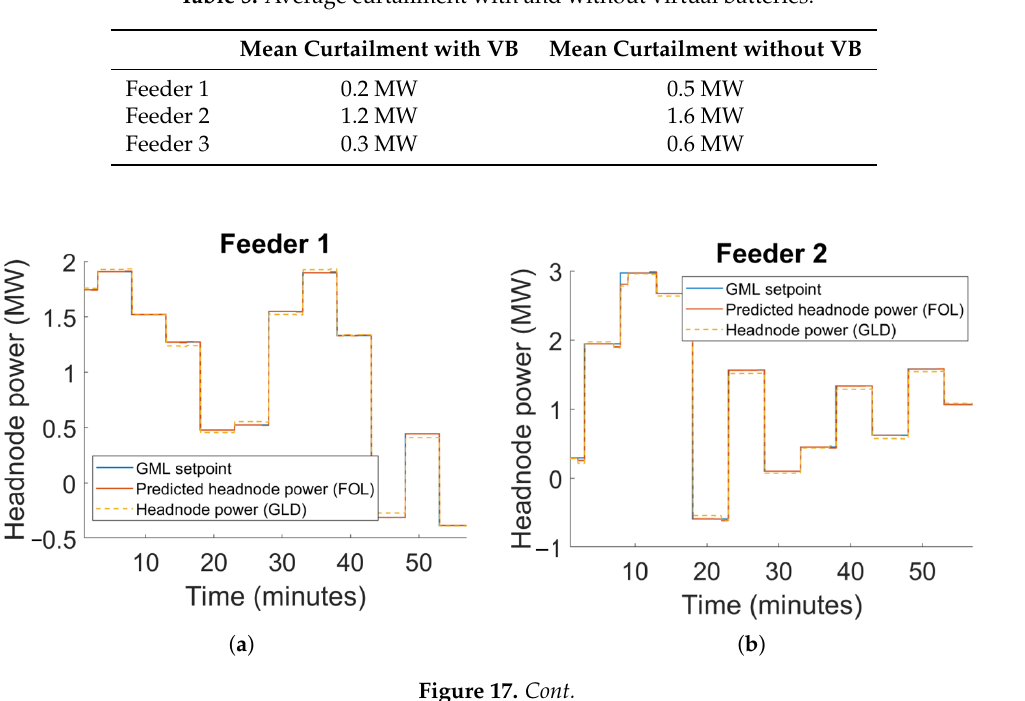
Table 5. Average curtailment with and without virtual batteries.